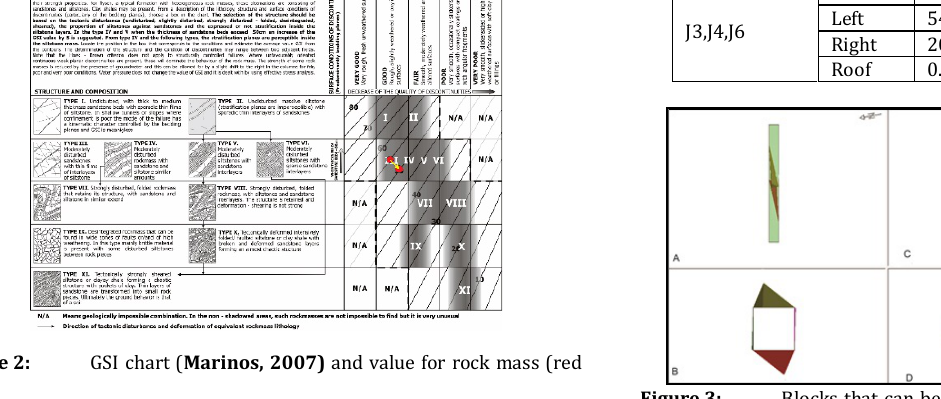
Figure 3: Blocks that can be formed from combination of J2J4J6 in four views. A – Top view; B – Front view; C – 3D view; D – Side